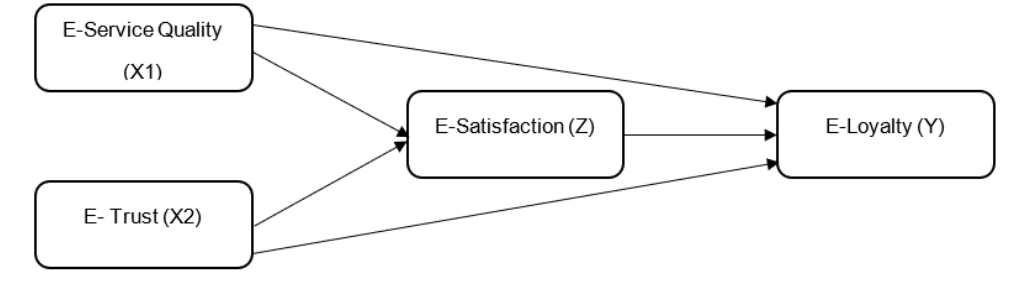
Figure 1: Research Framework and